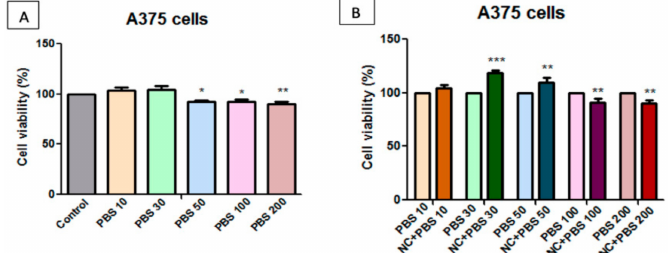
Figure 11. A —E ff ect of PBS at di ff erent concentrations on human melanoma—A375 cell viability at 24 h post-stimulation. Results are presented as cell viability rate (%) normalized to control cells (no stimulation); B —The e ff ect of di ff erent concentrations of NC sample on A375 cell viability. Results